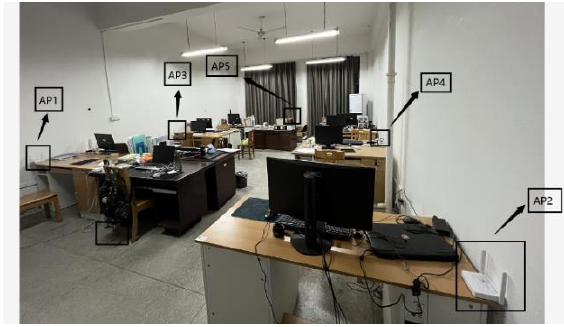
Figure 2. Realistic view of the experimental